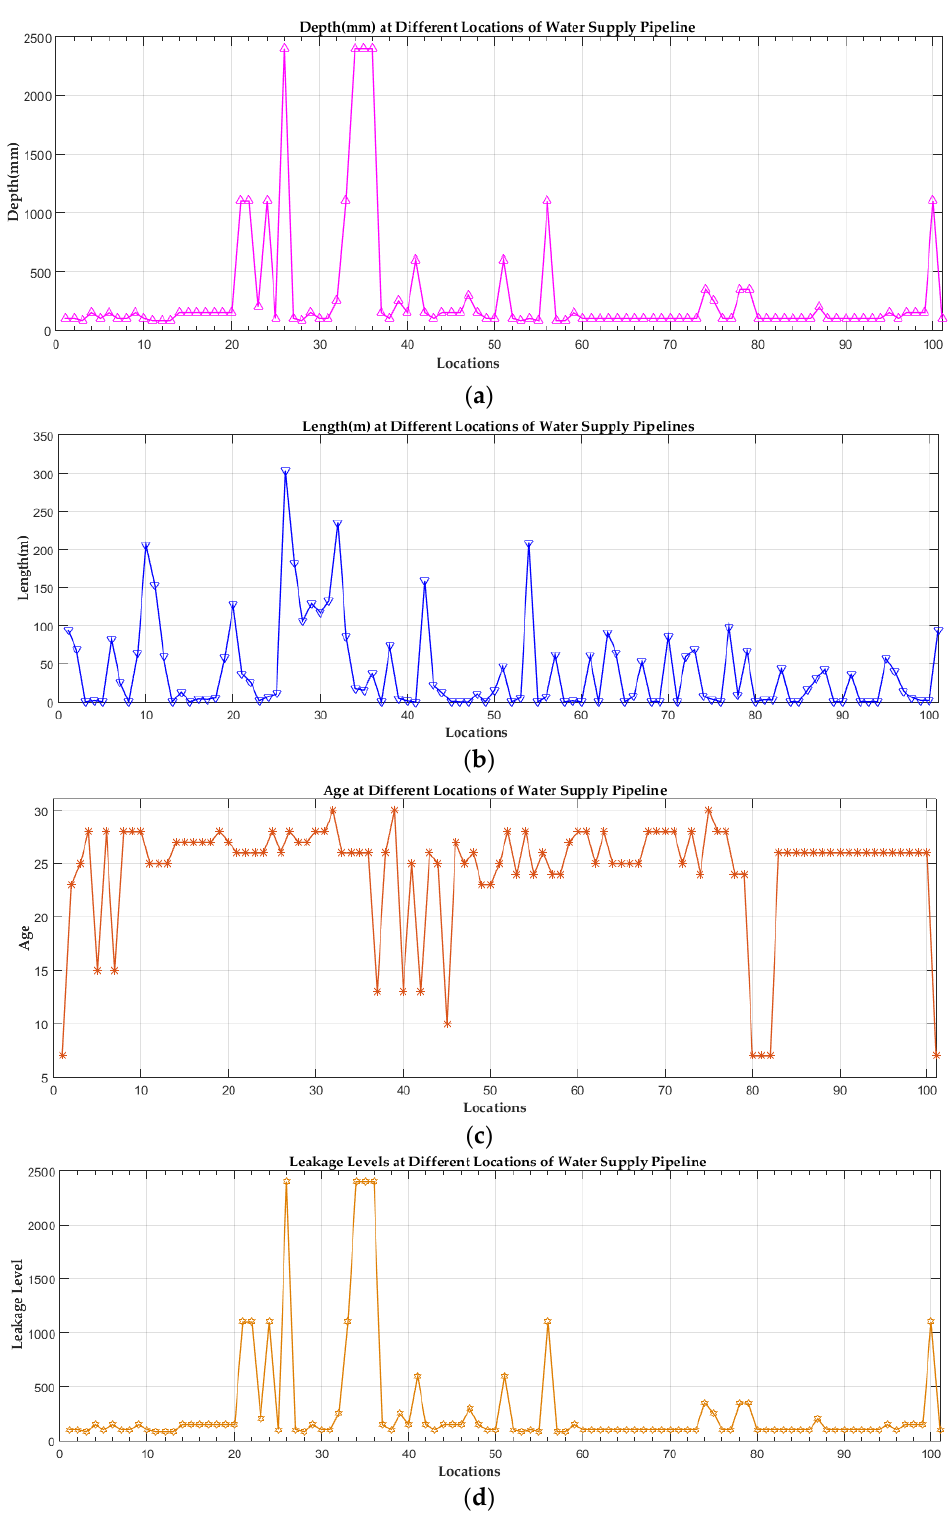
Figure 10. Input data of parameters: ( a ) depth; ( b ) length; ( c ) age; and ( d ) leakage. The risk index values calculated by the proposed CHFIS method based on the given four parameters is illustrated in Figure 11. The red color lines represent the actual risk index values, and the blue color represents the estimated risk index values.